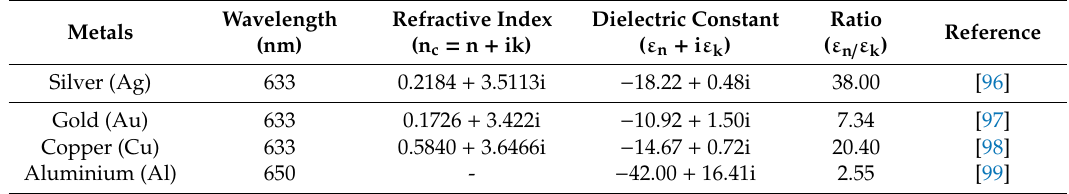
Table 4. Values of the refractive index and dielectric constants for the di ff erent metals.